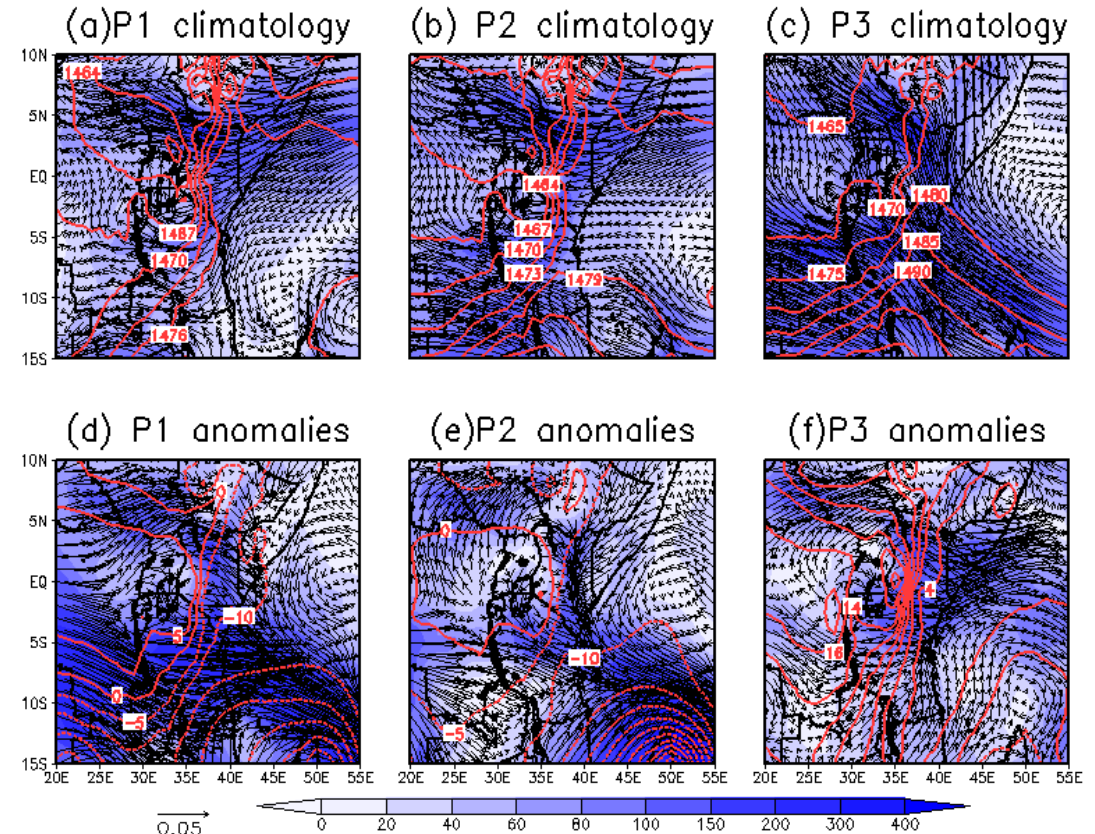
Figure 7. Climatological (top) and anomalous (bottom) circulation during wet periods P1–P3. 850 hPa moisture flux anomalies (vectors), scalar q-flux (shaded), and 850 geopotential height (red contours).